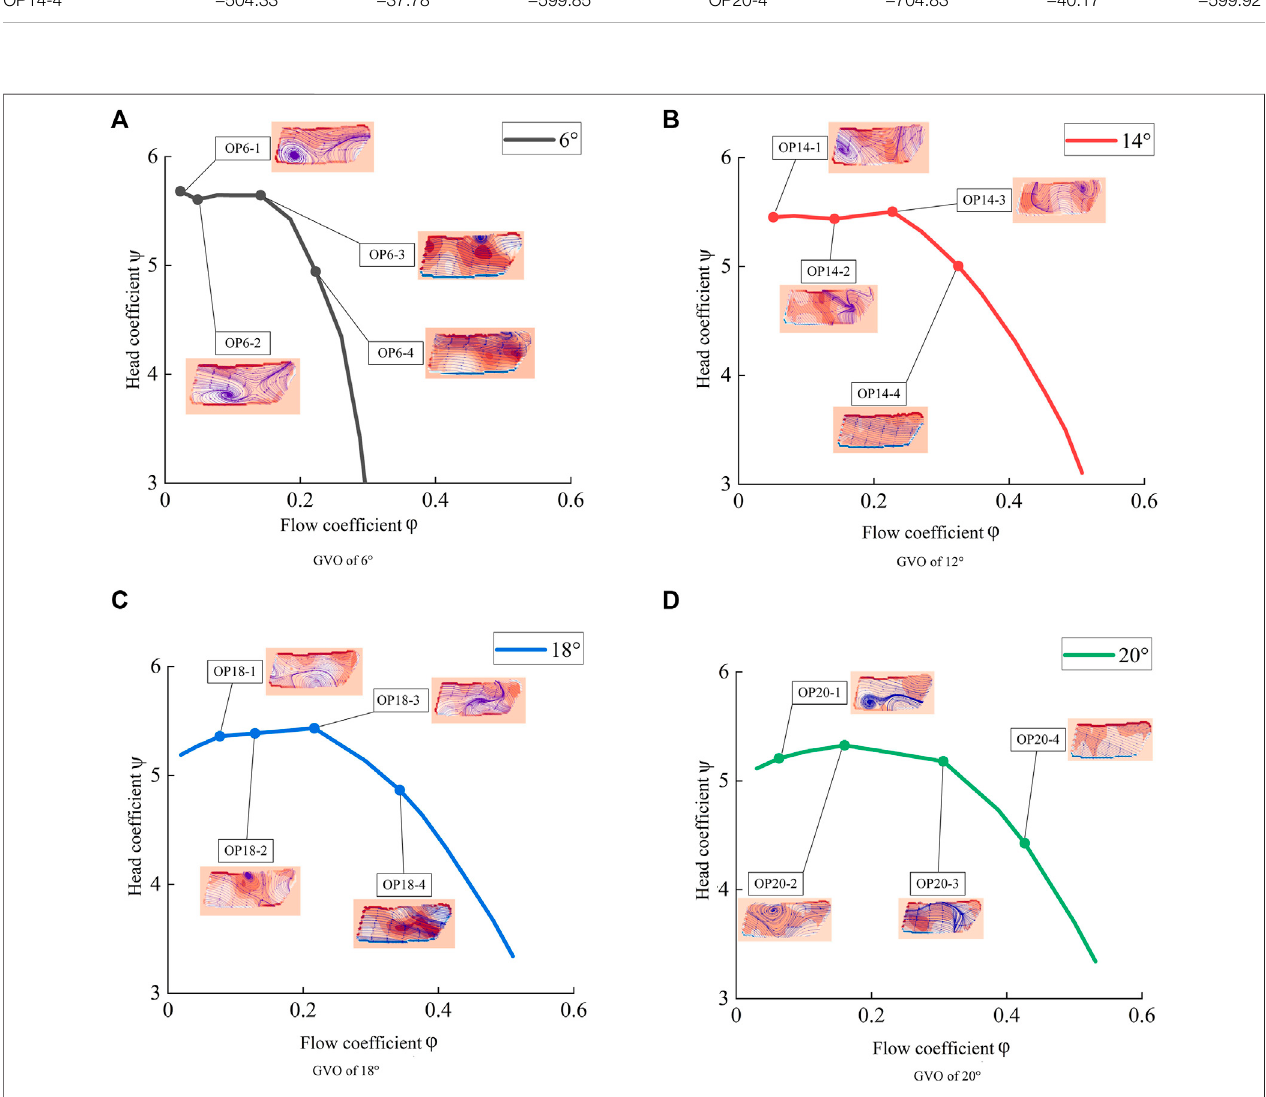
FIGURE 11 | Test results are on the hump curve. (A) GVO of 6 ° (B) GVO of 12 ° (C) GVO of 18 ° (D) GVO of 20 ° .